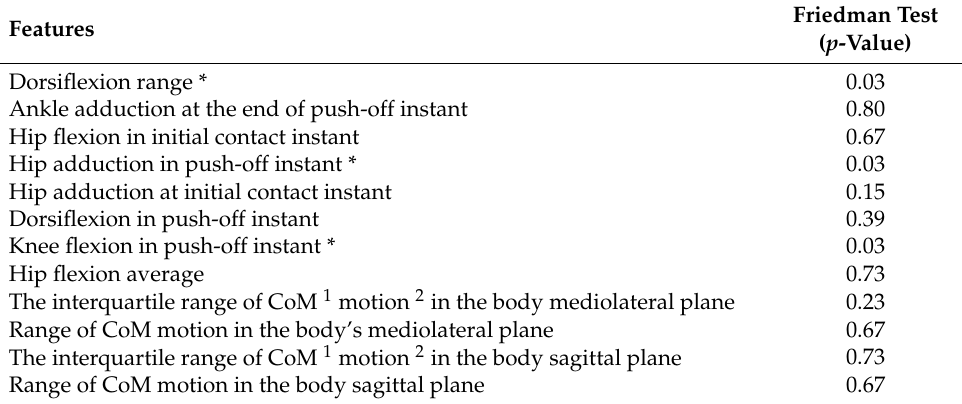
Table 1. On-ice distinctive features that differentiate high- and low-calibre hockey players on ice are listed here. The Friedman test was used to investigate whether they significantly differ in high- and low-calibre skating on synthetic ice experiments. The features with a p -value lower than or equal to 0.05 was labelled by an asterisk (*) and were used to classify high- and low-calibre skaters using KNN (Table 2).